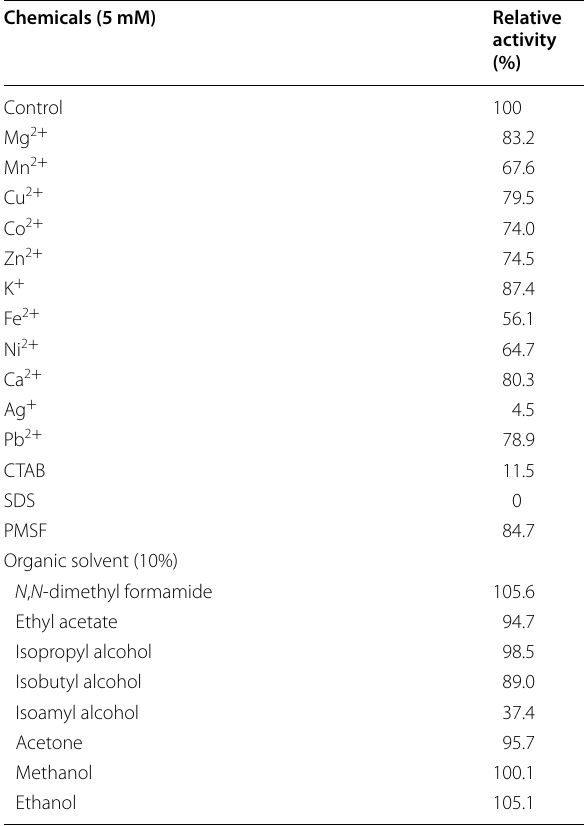
Table 1 Effects of different chemicals on esterase